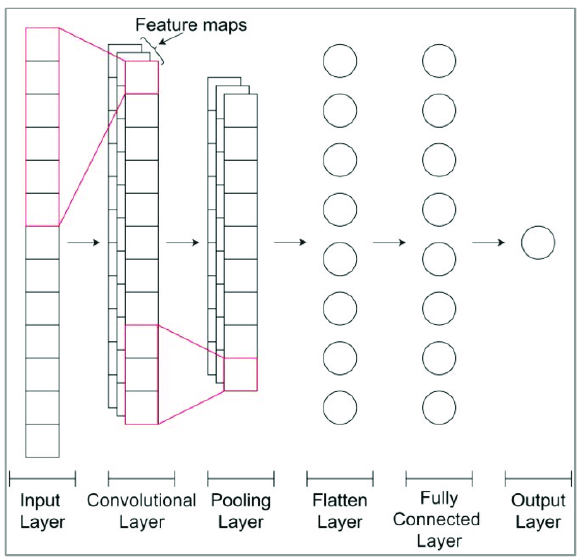
Figure 1. One-dimensional convolutional neural network (1D CNN)